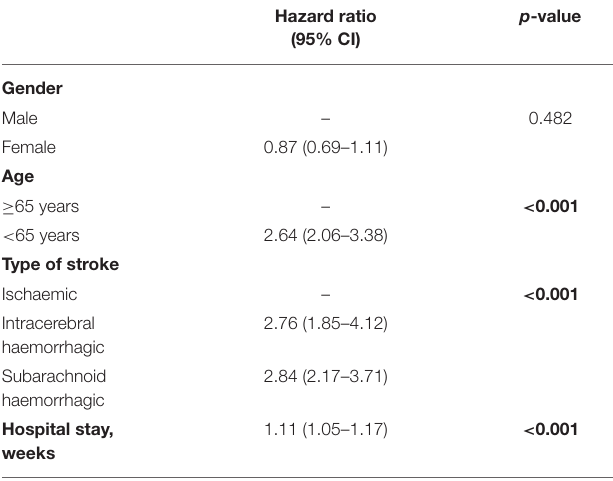
TABLE 1 | Demographic characteristics of people with and without PSE. TABLE 2 | Multivariate cox regression modeling of independent predictors of